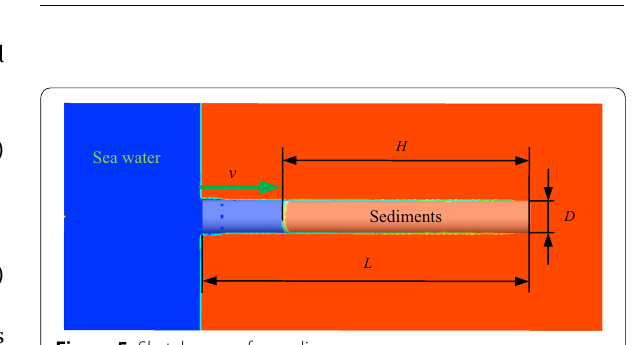
Figure 5 Sketch map of